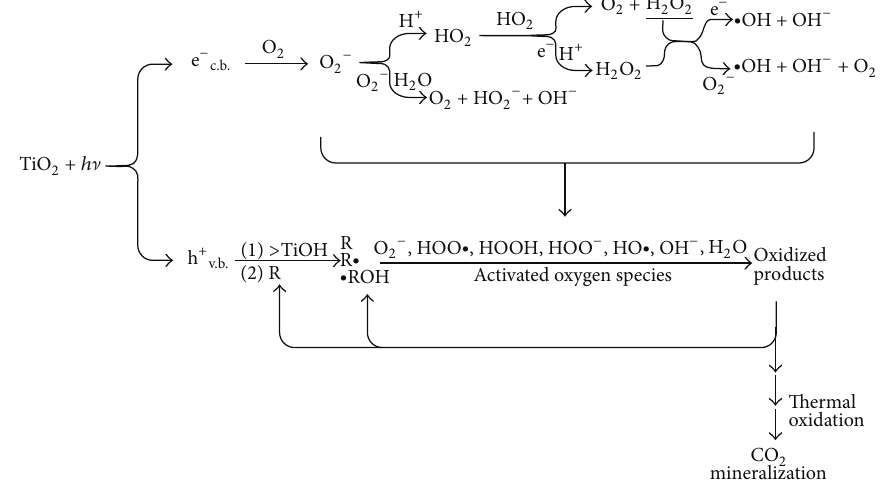
Figure 10: The photocatalytic reactions with electrons and holes [121].